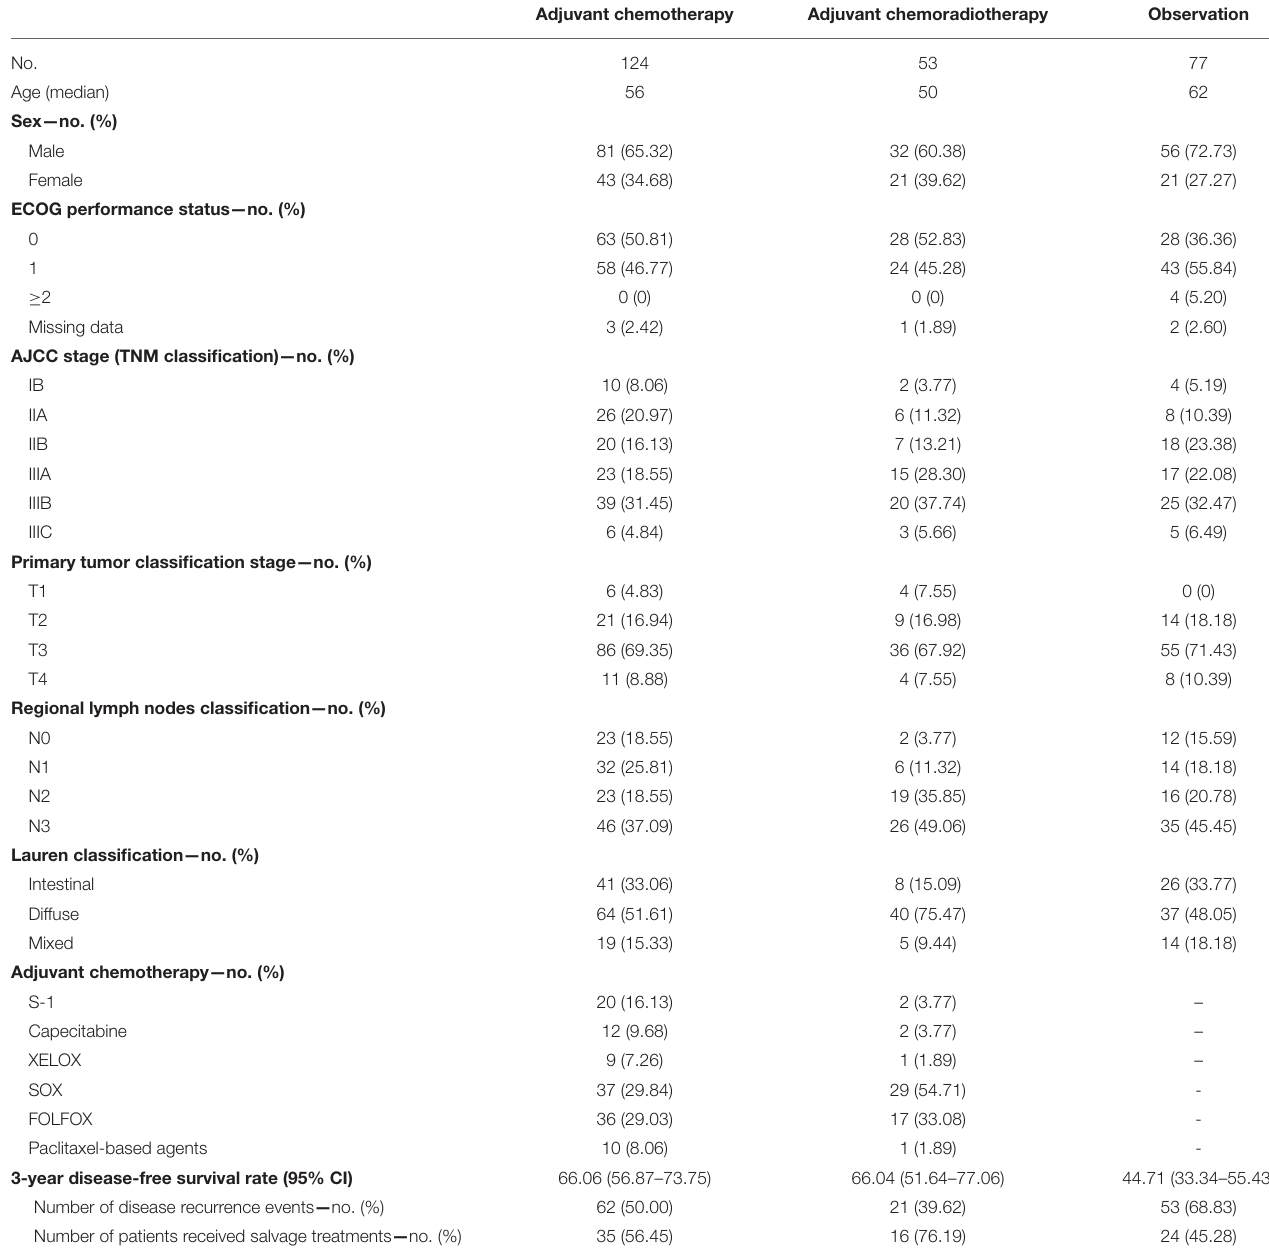
TABLE 2 | Baseline demographic and clinical